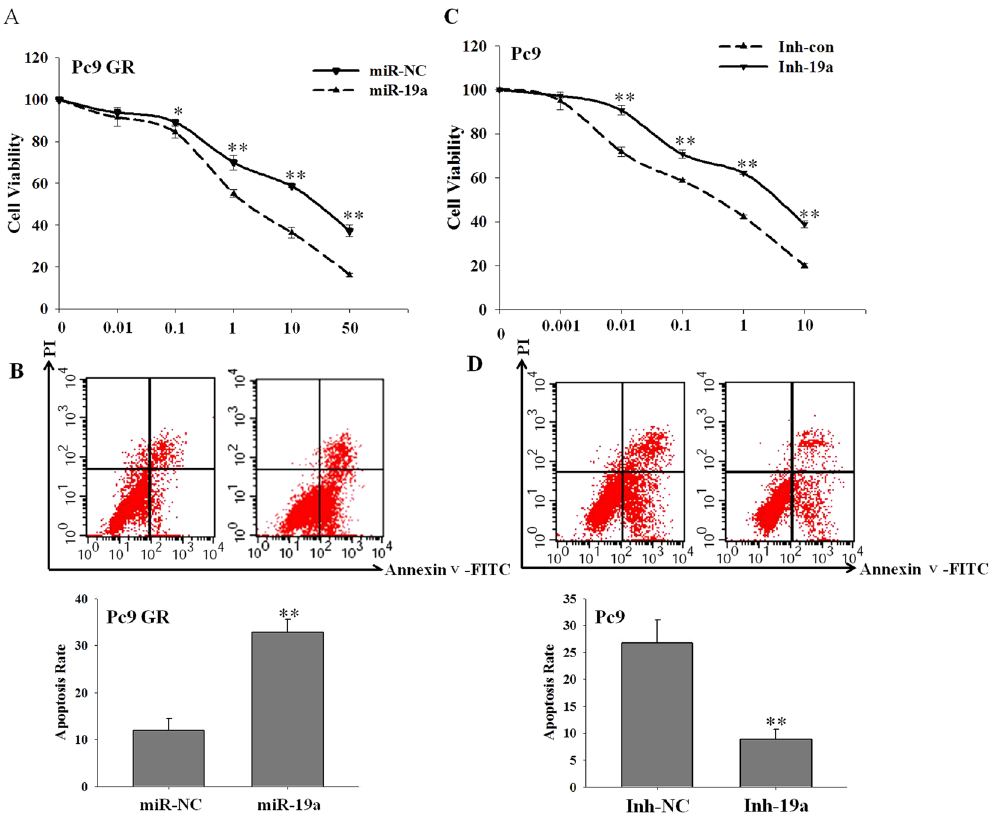
Figure 2. miR-19a overexpression attenuates gefitinib resistance in NSCLC cells ( A ). Pc9 GR (3000/plate) cells were transfected with miR-19a mimics (miR-19a) or the negative control (miR-NC) at a final concentration of 100 nM. The cells were then treated with different doses of gefitinib for 72 h, and viability was assessed using CCK8; ( B ) Pc9 GR cells were transfected with miR-19a or miR-NC and treated with 5 μ M gefitinib, and apoptosis was then measured by Annexin V-PI after 48 h; ( C ) Pc9 cells (3000/plate) were transfected with miR- 19a inhibitor (Inh-19a) or the negative control (Inh-NC) at a final concentration of 100 nM before being treated with different doses of gefitinib for 72 h and measuring cell viability using CCK8; ( D ) Pc9 cells were transfected with Inh-19a or Inh-NC and treated with 0.1 μ M gefitinib before measuring apoptosis by Annexin V-PI after 48 h. (The results above were reproducible in three independent experiments, ** p <